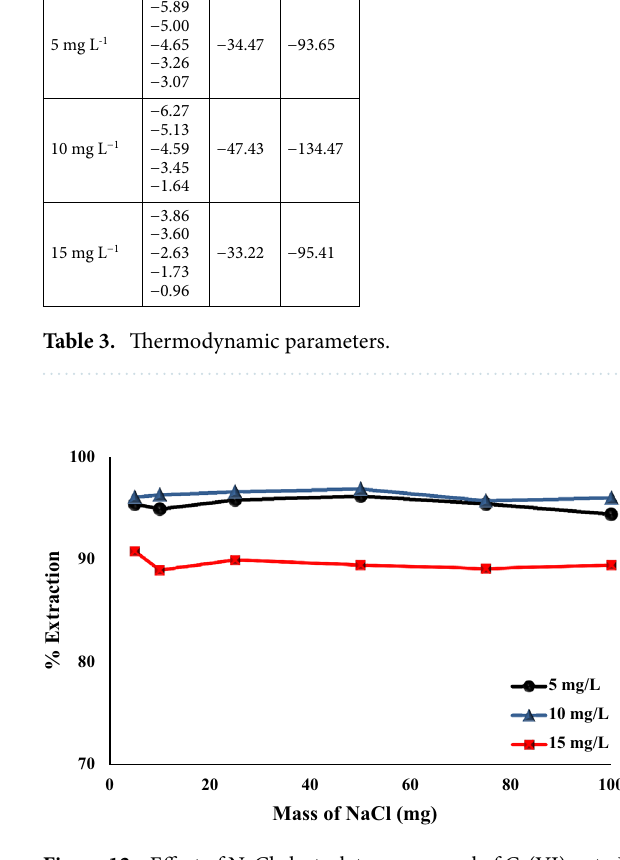
Figure 12. Effect of NaCl electrolyte on removal of Cr(VI) onto Fe 0.75 Cu 0.25 -BDC@Alg-MoO 3